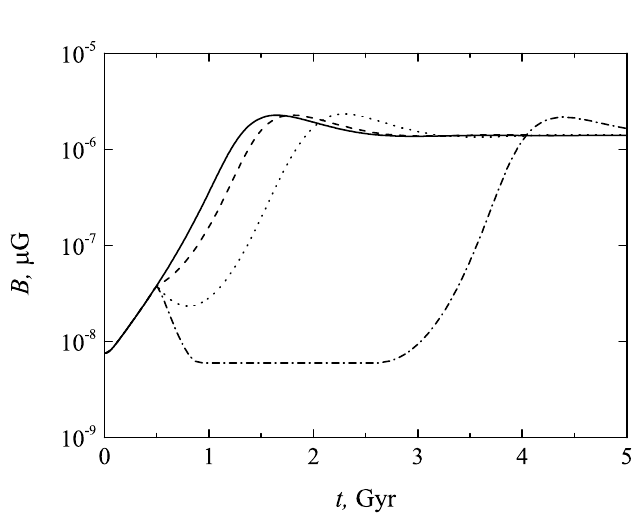
Fig. 1. Magnetic field evolution for the deterministic model with different values of surface star formation rate: Σ SFR = 0 : 004 M ⊙ yr − 1 kpc − 2 (the solid line); Σ SFR = 0 : 01 M ⊙ yr − 1 kpc − 2 (the dashed line); Σ SFR = 0 : 02 M ⊙ yr − 1 kpc − 2 (the dotted line), and Σ SFR = 0 : 1 M ⊙ yr − 1 kpc − 2 (dot-dashed